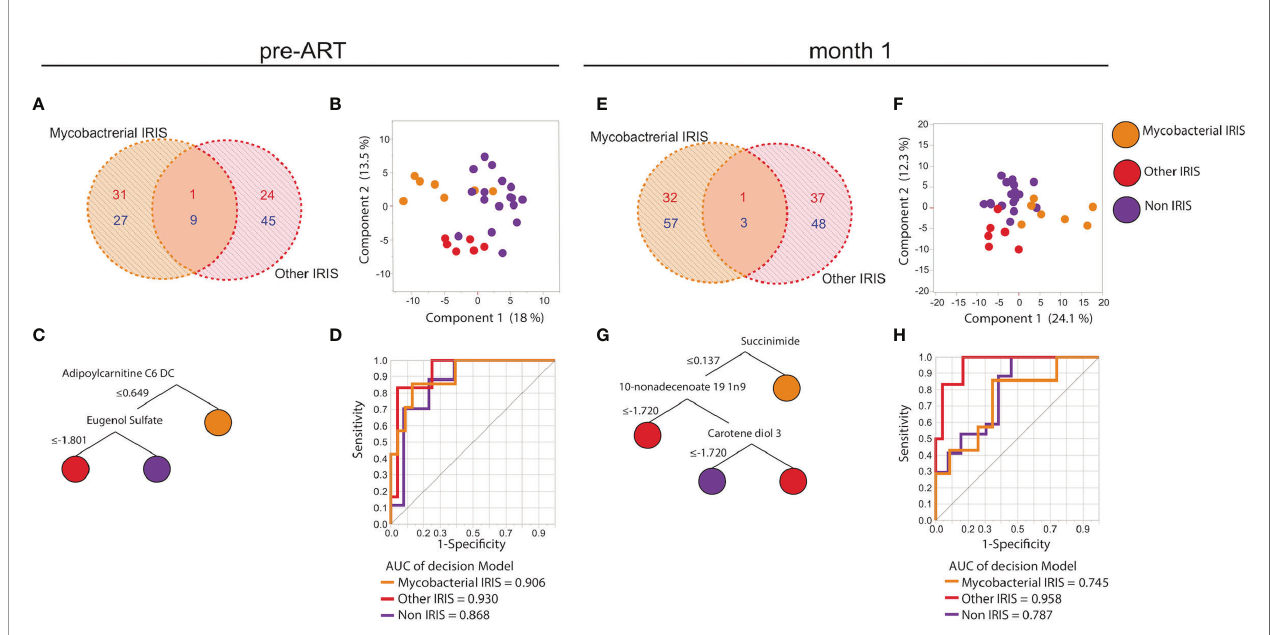
FIGURE 5 | Unique metabolic signatures in different types of IRIS. Venn diagrams illustrating the number of unique and shared DEMs comparing mycobacterial IRIS to other types of IRIS at the pre-ART (A) and month 1 (E) time points are shown. DEMs were used in a PCA plot to depict dimensionally reduced data distribution of the mycobacterial IRIS, other types of IRIS, and non-IRIS groups at the pre-ART (B) and month 1 (F) time points. Decision tree models based on the DEMs are presented for the pre-ART (C) and month 1 (G) time points. ROC analysis of the metabolites identi fi ed by the decision trees were used to test discrimination power between each study group for pre-ART (D) and month 1 (H) time points. P-values for all the AUC measures were < 0.001.